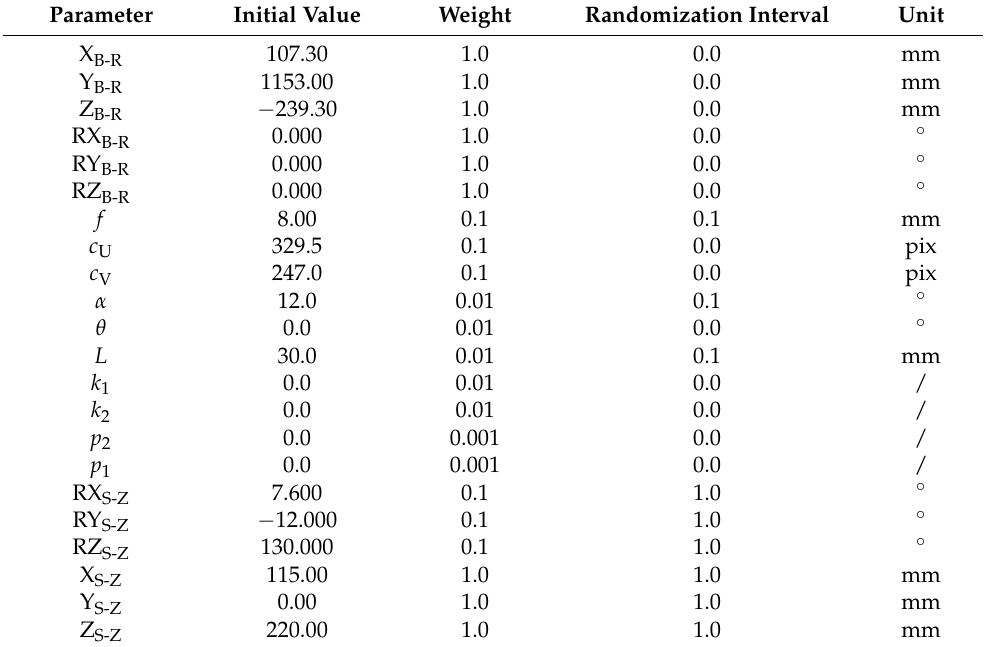
Table A1. Initial values of optimized transformation parameters, their weights and randomization